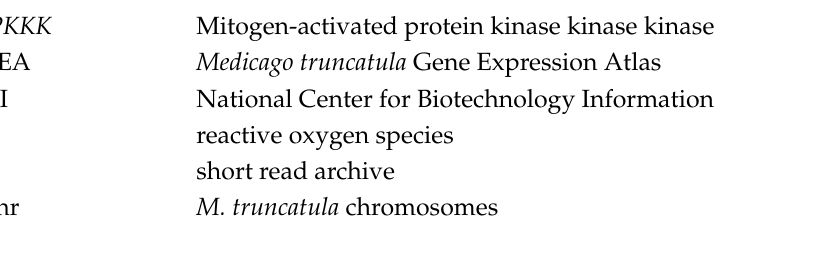
Figure S1: Phylogenetic tree analysis of both MtMAPKKK and AtMAPKKK